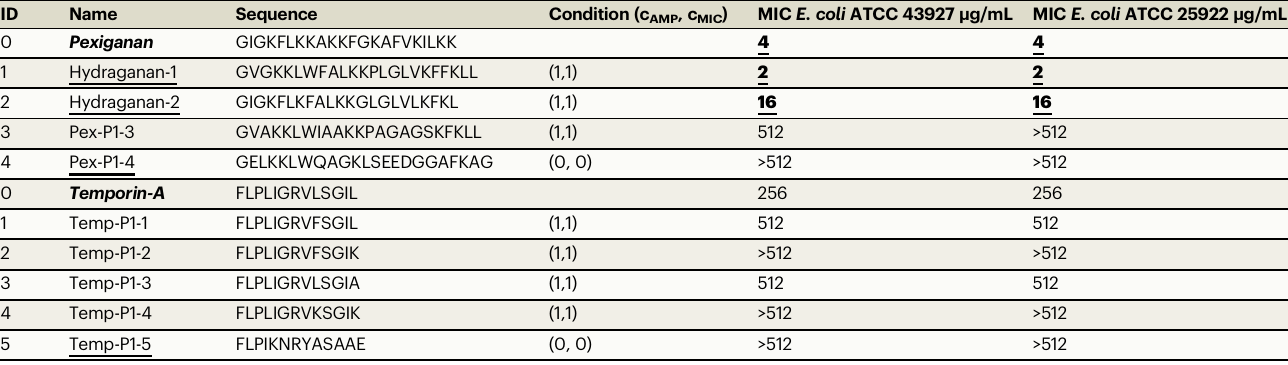
Table 1 | Pexiganan and Temporin-A analogues obtained in the analogue generation process without additional preselection ID